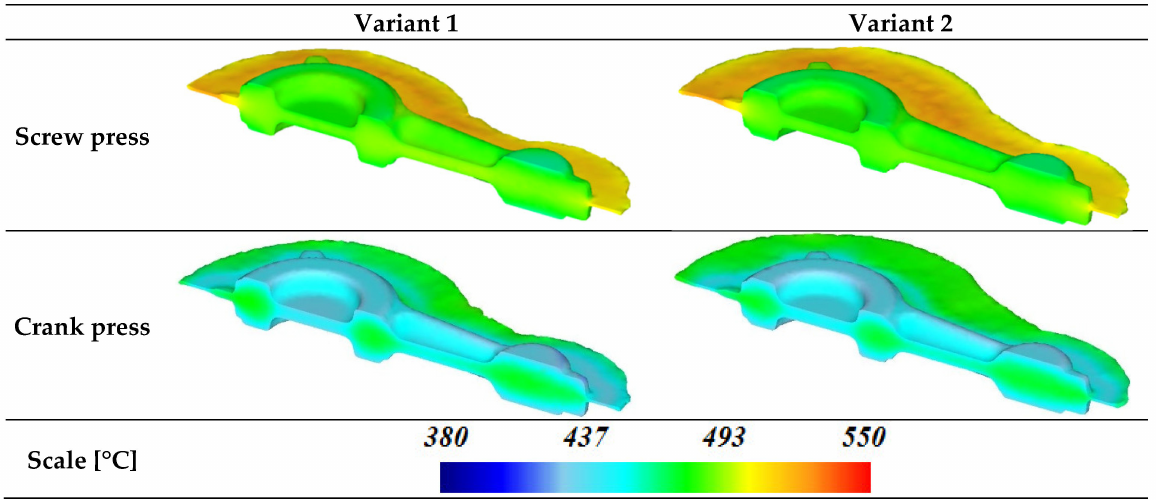
Figure 20. Temperature distribution for connecting rod forgings made of AB-71100 alloy formed based on the new